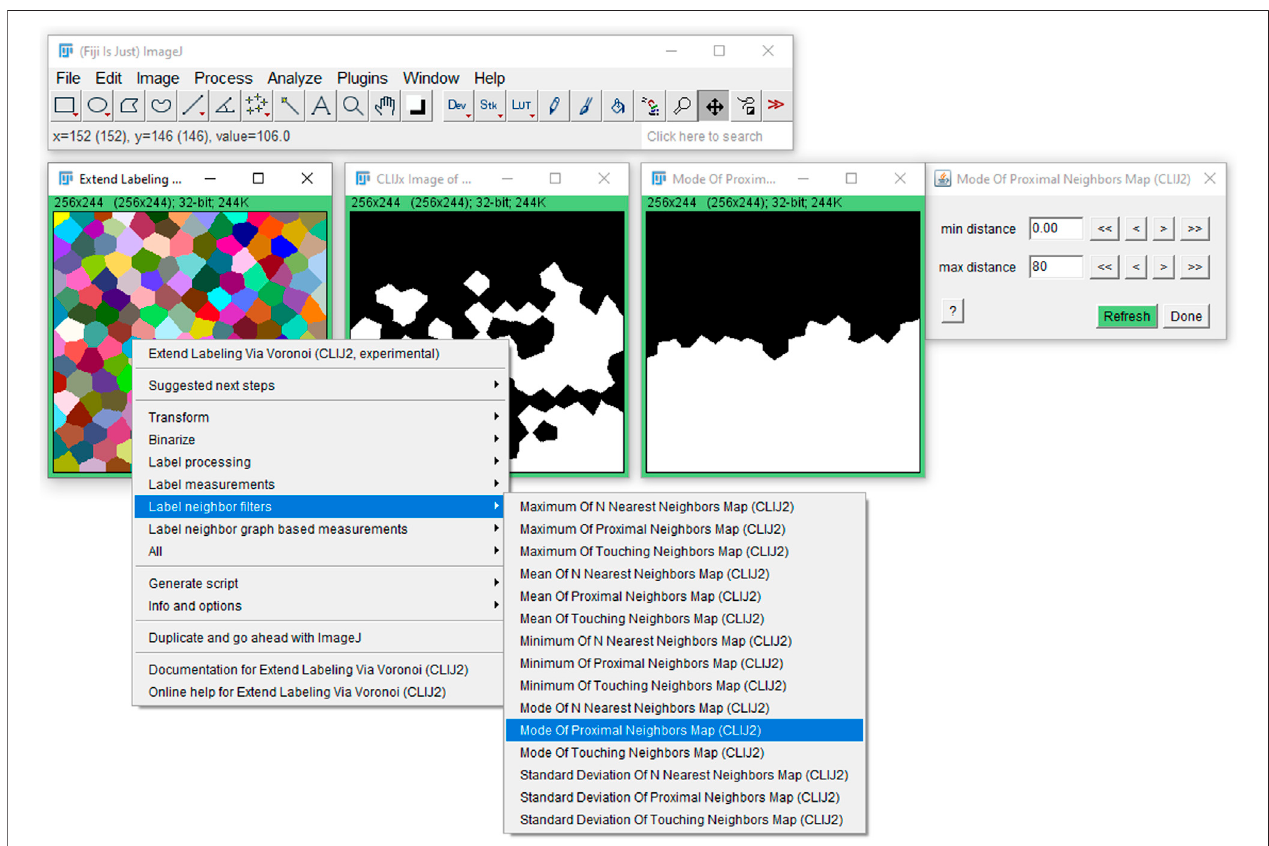
FIGURE 5 | User interface in Fiji: The label neighborhood fi lters are available in Fiji via the CLIJ2-assistant user interface on a right-click. After clicking on the given fi lter, a new window opens and a corresponding dialog where the user can fi ne tune parameters such as the maximum distance of cells to be considered in the fi lter as